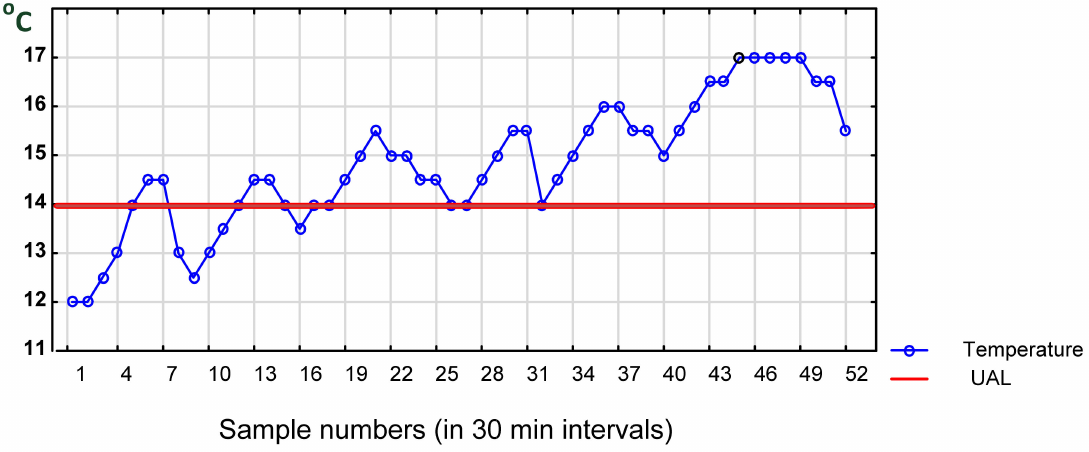
Figure 7. Temperature trend due to repeated opening/leaving them open and closing of a refrigerated truck. Source: own data collected in 30 min.